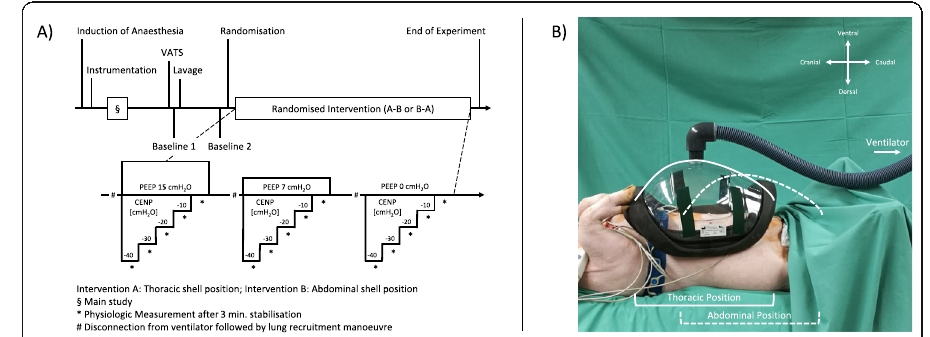
Fig. 1 Time course of the experiment ( a ) and positioning of the shell on the pig thorax ( b ). Legend: VATS, video-assisted thoracoscopy; PEEP, positive end-expiratory pressure; CENP, continuous